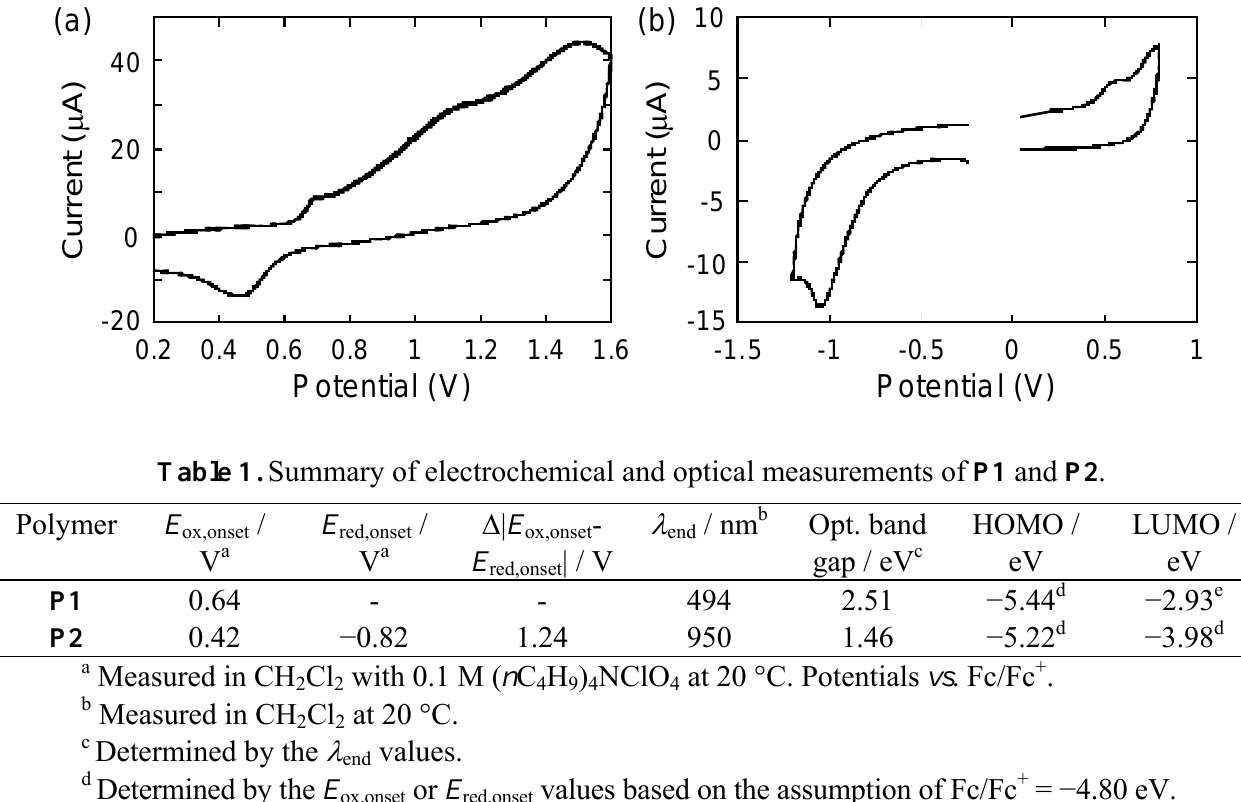
Cl with 0.1 M 2 2